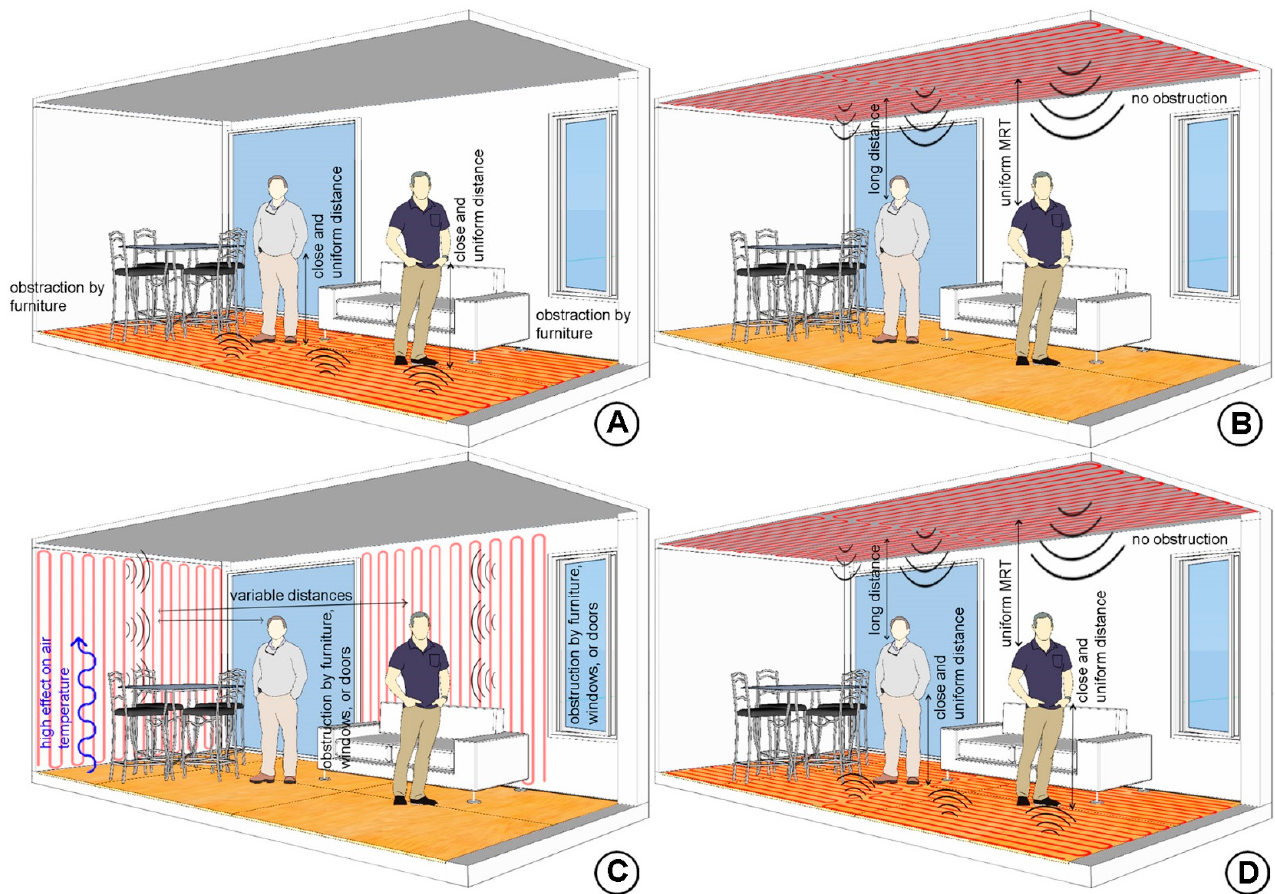
Figure 13. ( A ) Floor-mounted radiant systems; ( B ) Ceiling-mounted radiant systems; ( C ) Wall- mounted radiant systems; ( D ) Floor and Ceiling-mounted radiant systems. Source: First author.